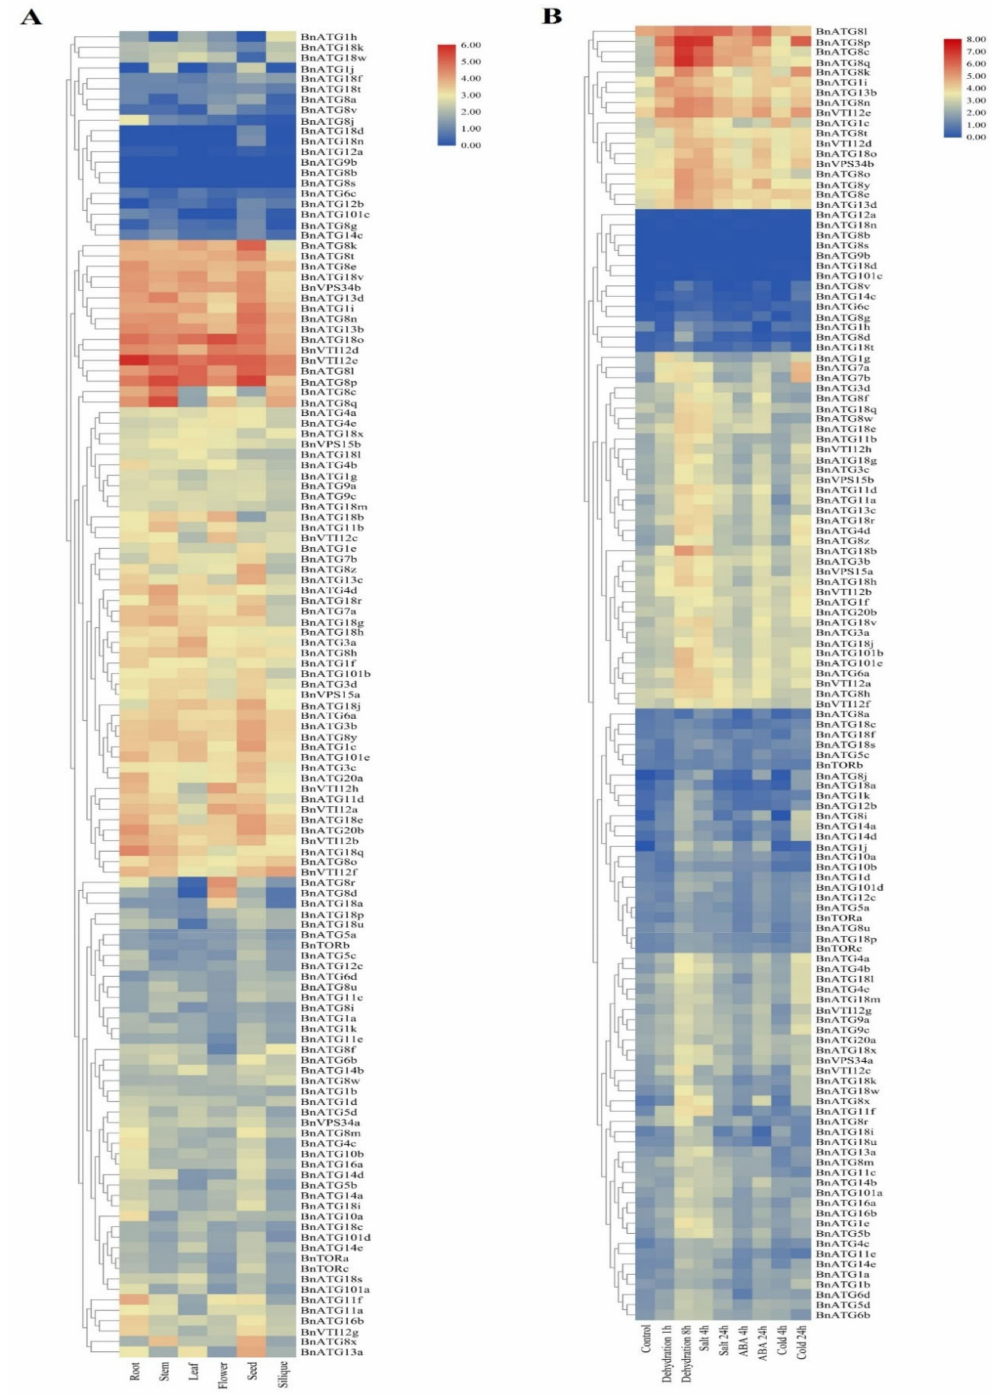
Figure 10. The expression pattern of BnATG genes ( A ) in di ff erent tissues, ( B ) under diverse abiotic stresses. The color boxes indicate expression values, the lowest (blue), medium (Pale goldenrod), and the highest (red). The heatmap was generated using log10 (TPM + 1)